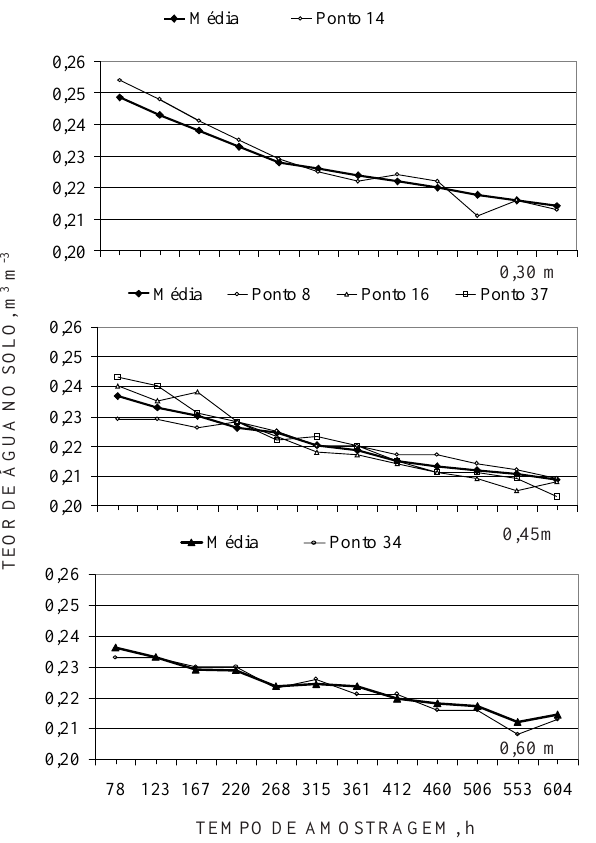
Figura 6. Comparação entre os teores médios de água no solo e os teores de água nas posições com estabilidade temporal, ao longo do tempo.